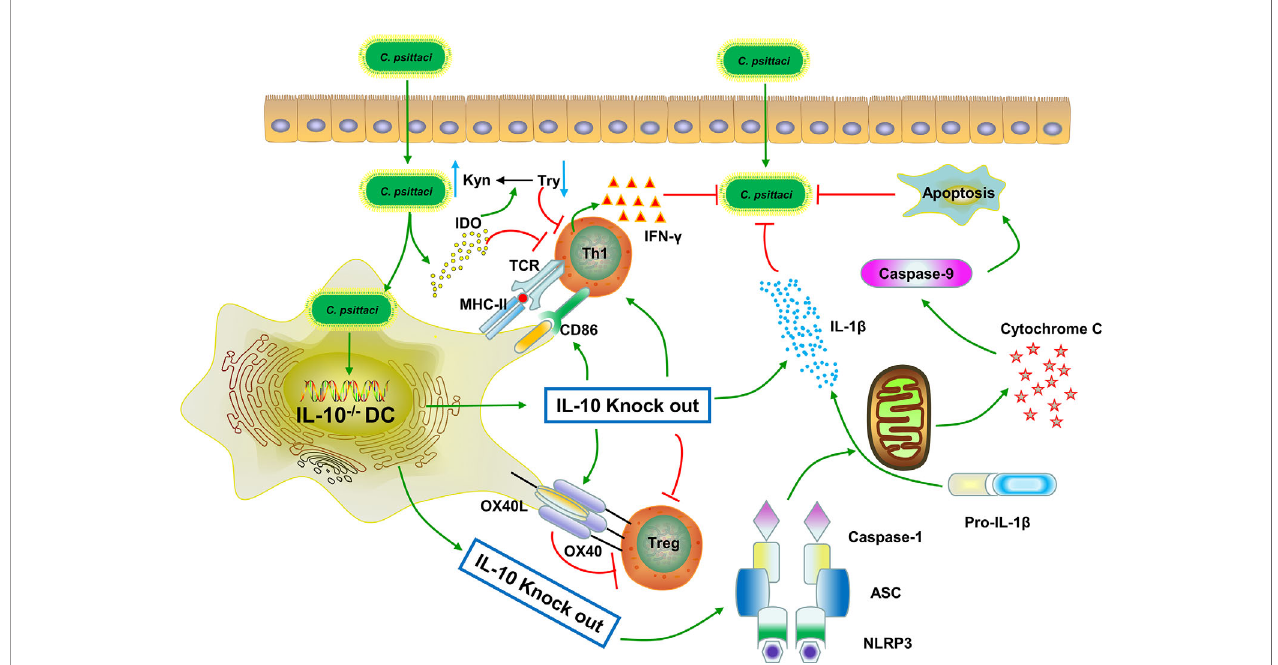
FIGURE 9 | Possible interaction between IL-10 and DCs during C. psittaci infection. IL-10 knockout enhanced DC maturation, T cell proliferation, and increased Th1 cytokine secretion during C. psittaci infection. IL-10 − / − improved the function of the de fi cient DCs by upregulating the OX40-OX40L, increasing CD4 + T cell proliferation and NLPR3 in fl ammasome assembly, downregulating IDO expression, and reducing Tregs, leading to DCs apoptosis and chlamydial clearance. The green line arrows denote promotion while the red line arrows denote